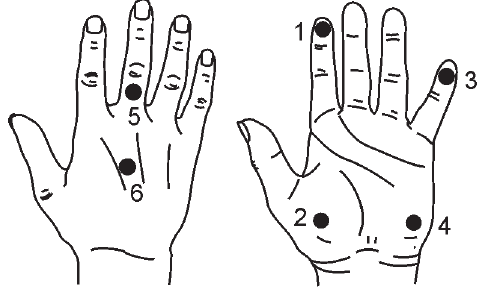
Figure 1. Cutaneous sensation testing sites. Sites 1–4 reflect glabrous skin and sites 5–6 hairy skin. Sites 1–2 have median nerve innervation, 3–4 ulnar nerve, and 5–6 radial nerve.